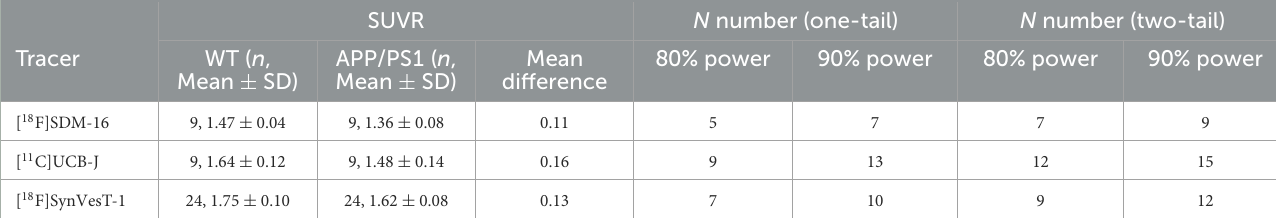
TABLE 1 Power analysis based on hippocampal SUVR of [ 18 F]SDM-16 (60–90min), [ 11 C]UCB-J (30–60min), and [ 18 F]SynVesT-1 (30–60min) in APP/PS1 and WT mice. SUVR N number